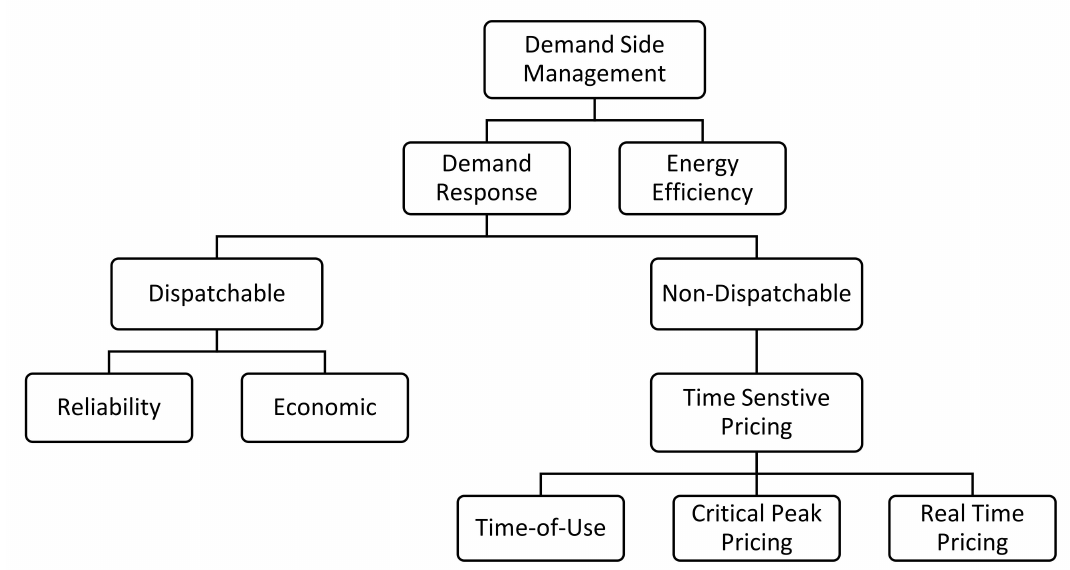
Figure 5. Classification of demand-side management